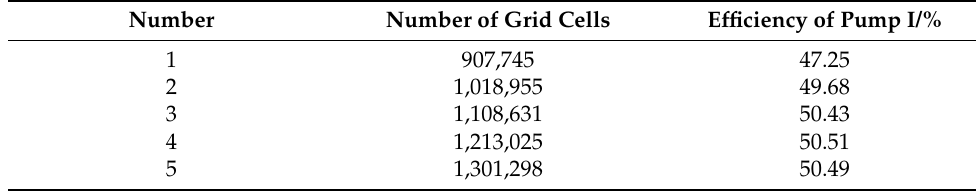
Table 1. Grid cell quantity